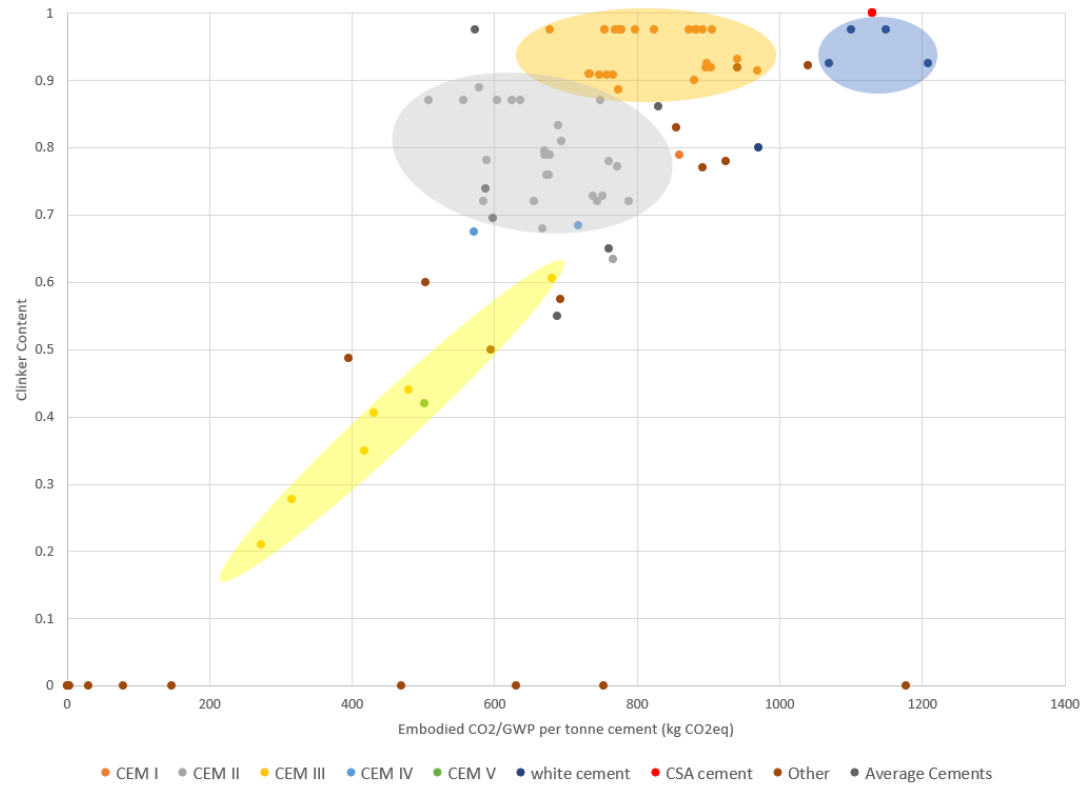
Figure 1. Graph showing relationship of Embodied Carbon for cements by clinker content, source [7].